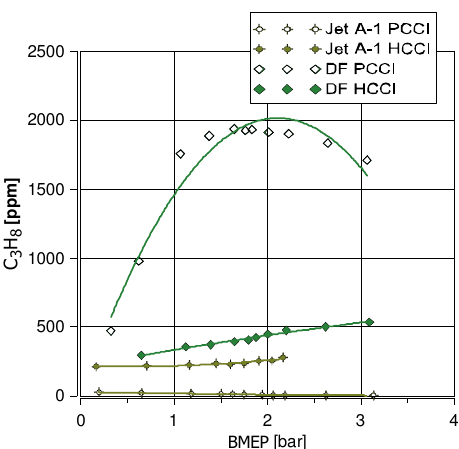
Fig. 10. Unburnt propane emission vs. BMEP for four modes of fuelling